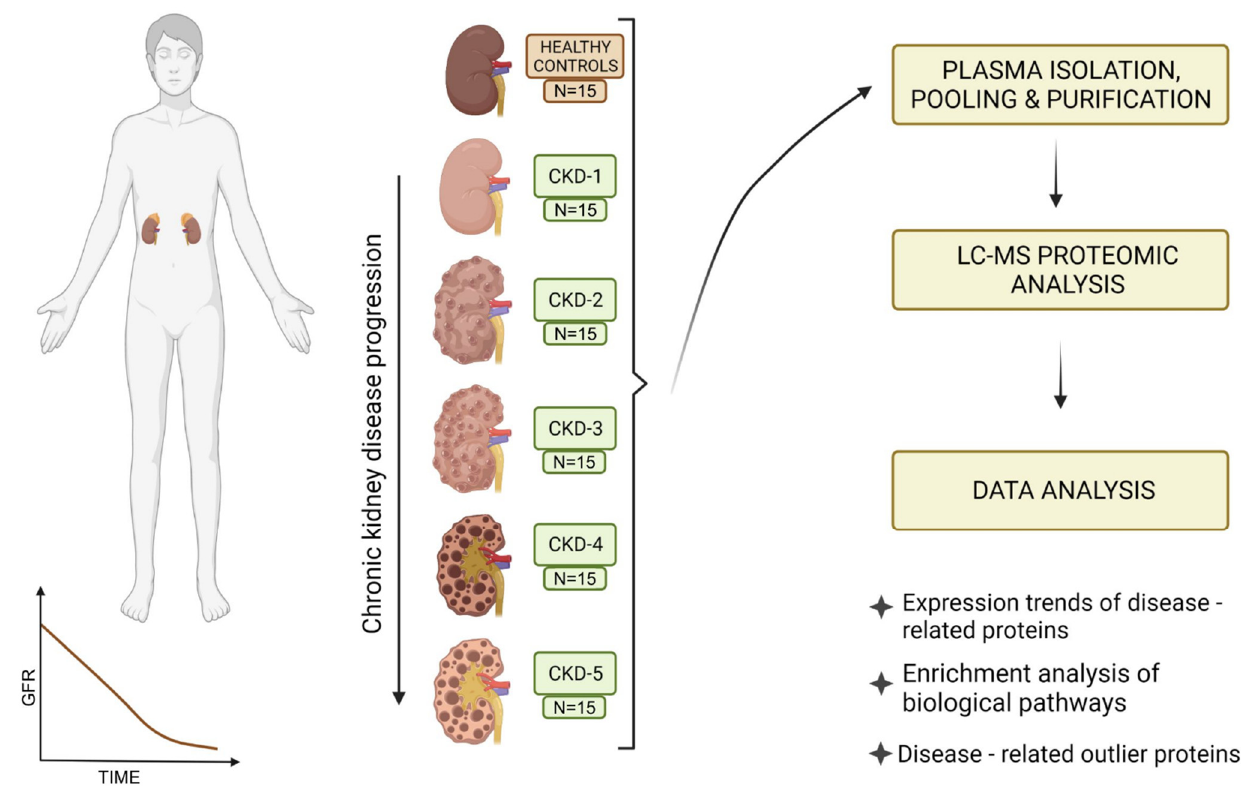
Figure 1. Study outline. Proteomic data was obtained from the pooled and purified plasma samples of patients with chronic kidney disease (CKD) including all stages from CKD 1 to CKD 5. The most relevant proteins related to kidney disease initiation and progressions were selected by manual curation, as well as kidney specific protein analysis was performed. Next, dynamic profiles of proteins identified in all samples, as well as outliers, were performed with an emphasis on the degree of renal failure at which the greatest changes were observed. Functional pathway analysis of proteins included in the ascending and descending protein abundance profiles was assessed.